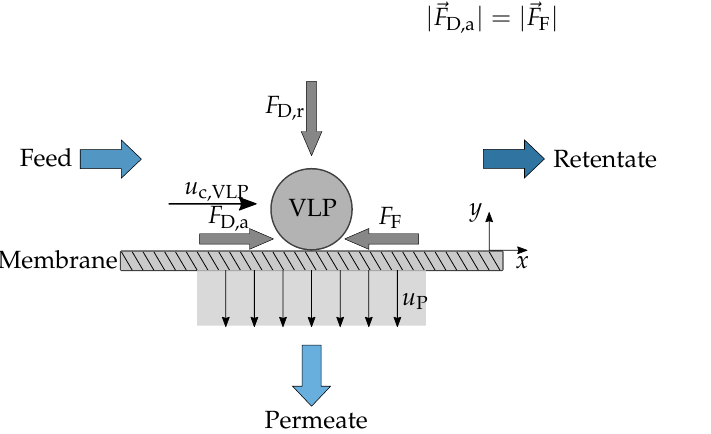
Figure 2. Schematic acting forces on a VLP located at the surface of the membrane according to Schock [24]. Figure adapted from [26]. (cid:126) F D,a is the drag force resulting from the resistance of the particle in the axial fluid flow, and its magnitude is given by Equation